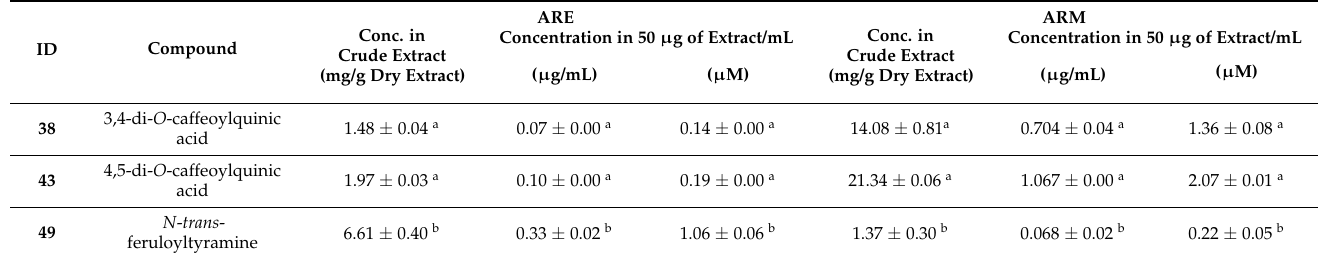
Table 3. Relative content of major phenolic compounds of ARE and ARM, expressed as: a mg